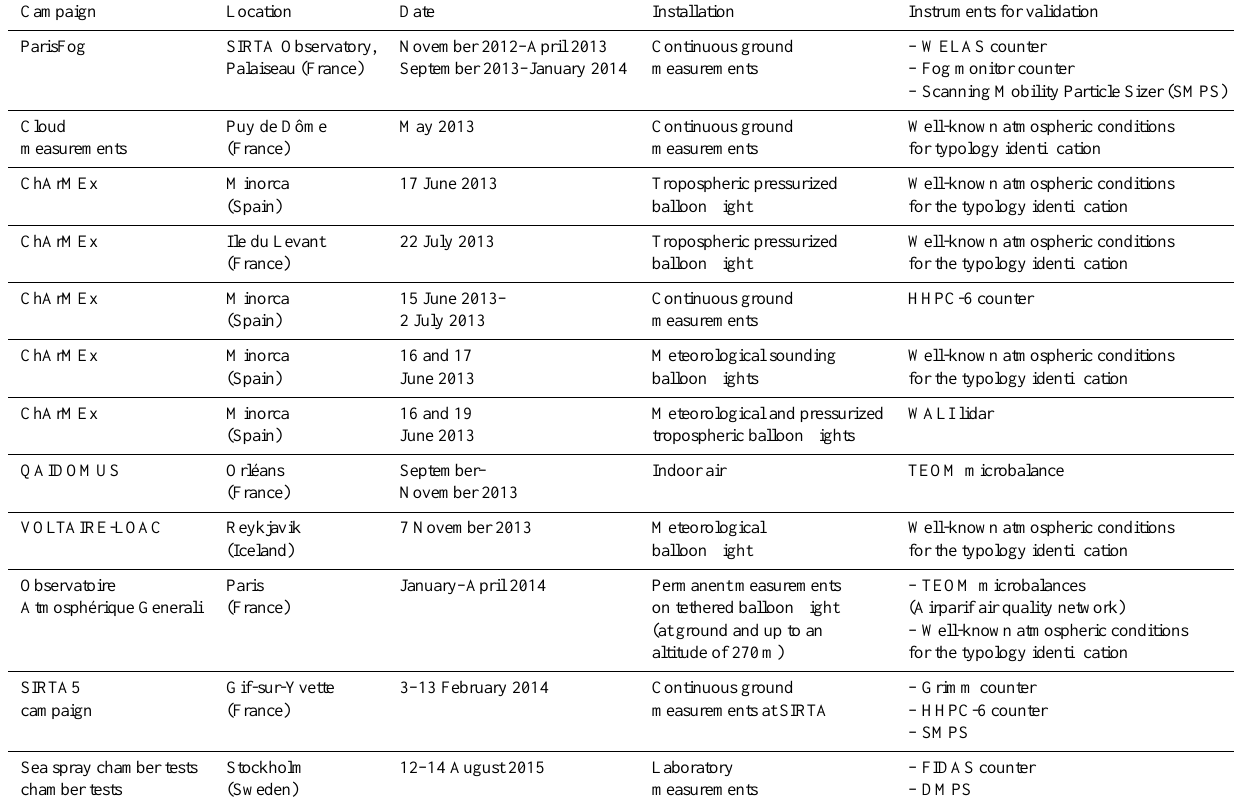
Table 2. Conditions of measurements for evaluation exercises.